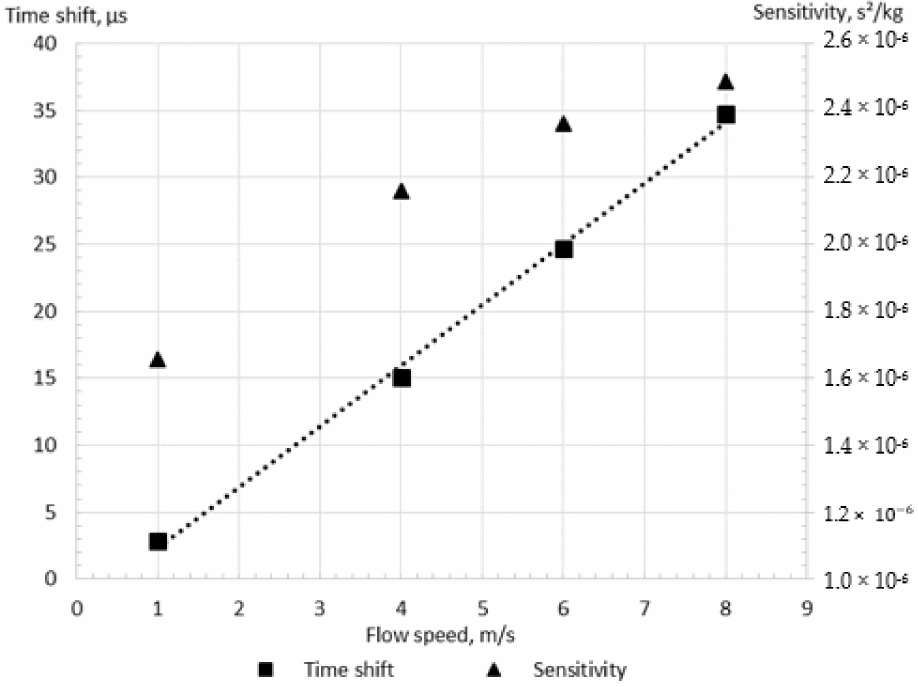
Figure 6. The linearity of the relationship between flow speed and time shift for the Case A, the shear stress turbulence